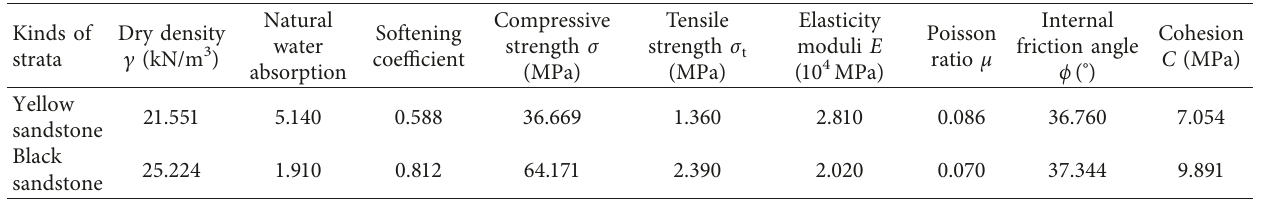
Figure 2: Simplified model of the bending test device. Table 1: Physical and mechanical parameters of